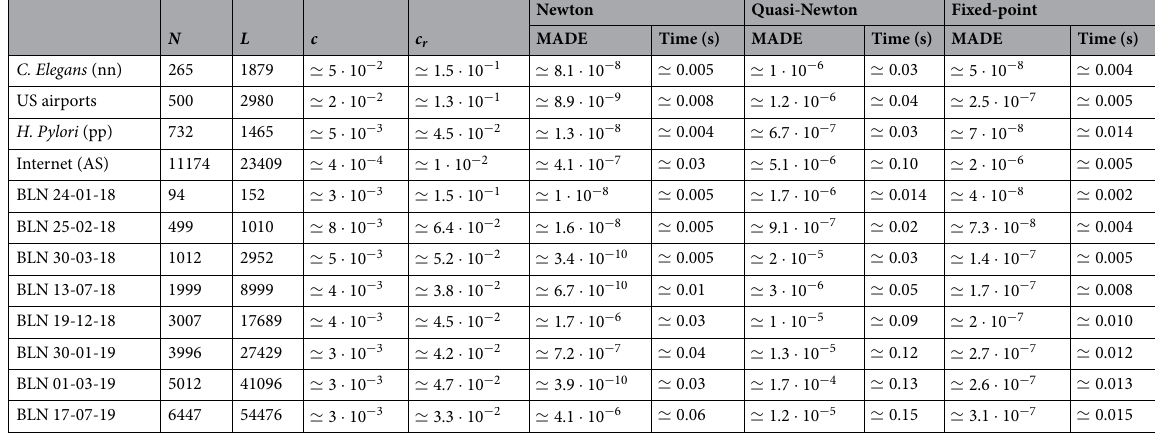
Table 1. Performance of Newton’s, quasi-Newton and the fixed-point algorithm to solve the reduced system of equations defining the UBCM, on a set of real-world BUNs (of which basic statistics as the total number of nodes, N , the total number of links, L , and the connectance, c stop either because the condition satisfied. For what concerns accuracy, the two most accurate methods are Newton’s and the fixed-point ones; for what concerns speed, the fastest method is the fixed-point one (although Newton’s one approximately requires the same amount of time on each specific configuration). Only the results corresponding to the best choice of initial conditions are